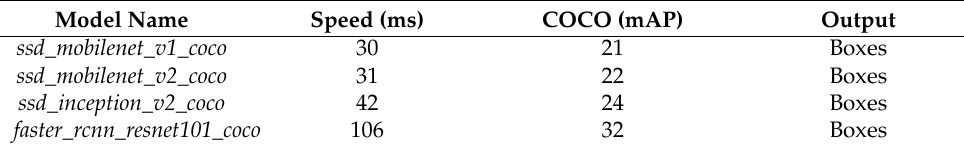
Table 1. Comparison of pre-trained models in Model Zoo collection based on COCO dataset [13]. The ssd_MobileNet_v1_coco and ssd_MobileNet_v2_coco are the SSD models with MobileNet v1 and v2 configurations, respectively; ssd_inception_v2_coco represents SSD with Inception v2 configuration, and faster_rcnn_resnet101_coco stands for Faster R-CNN with Resnet-101 (v1) configuration. All these configurations are used for the COCO